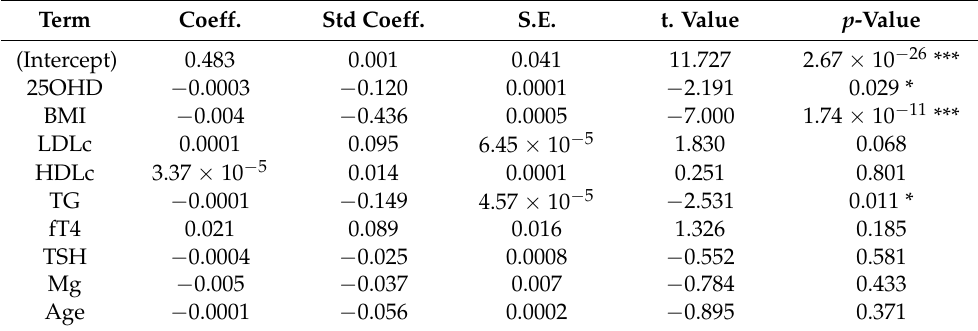
Table 6. A robust linear regression model describing the effects of 25OHD and several variables on QUICKI in the study